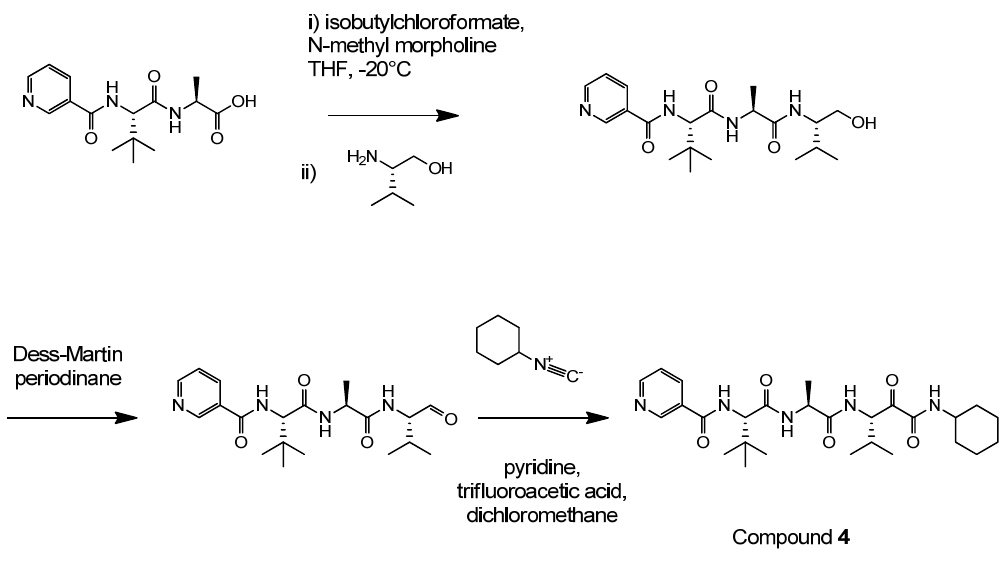
Scheme 5. Schematic